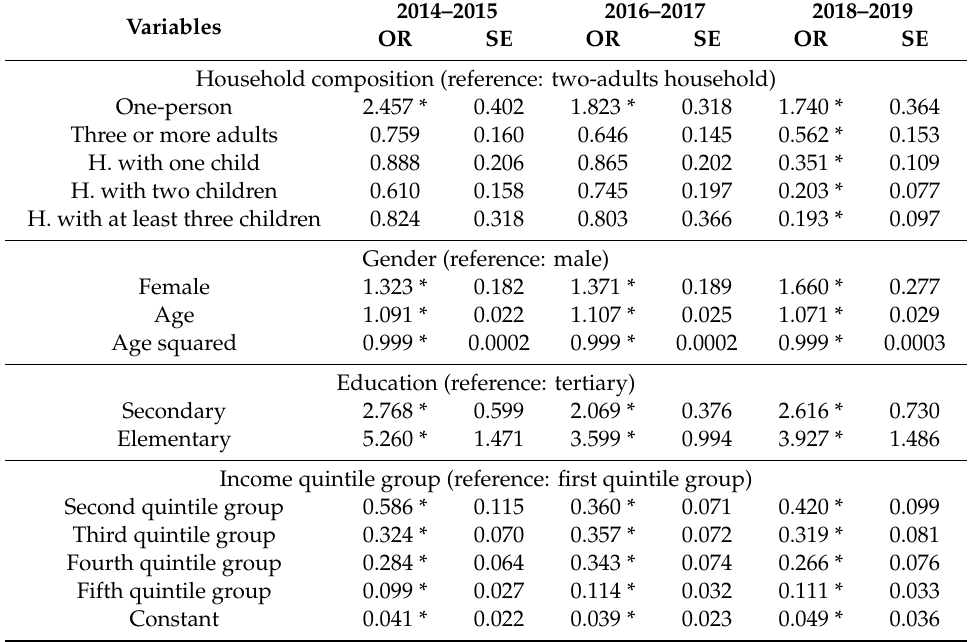
Table 4. Logistic regression models on food insecurity by set of variables including household composition, age and education.